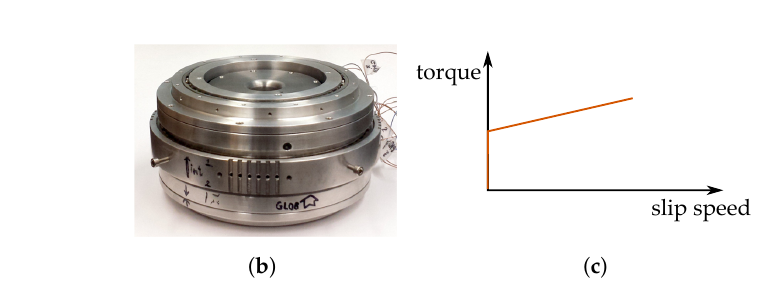
Figure 9. Of magneto-rheological (MR) fluid clutch: ( a ) Illustration ( b ) Photograph of a MR-fluid clutch for robotic application [39] ( c ) Torque vs. slip speed characteristics.